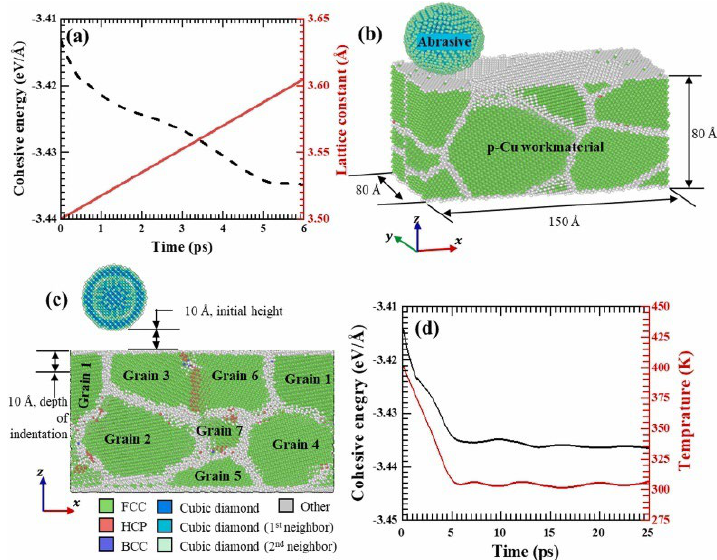
Figure 36. ( a ) Lattice optimization of the copper lattice with respect to cohesive energy, ( b ) dimensions of the atomistic model of p-Cu work material (a rectangular block of size 150 Å × 80 Å × 80 Å), and abrasive particle (spheres of sizes Ø43 Å and Ø57 Å) in perspective view, ( c ) front sectional view of the atomistic model of grains and their boundaries with initial height of abrasive and depth of nanoindentation and ( d ) equilibration graphs for cohesive energy and temperature for initial 25 ps [ 199].